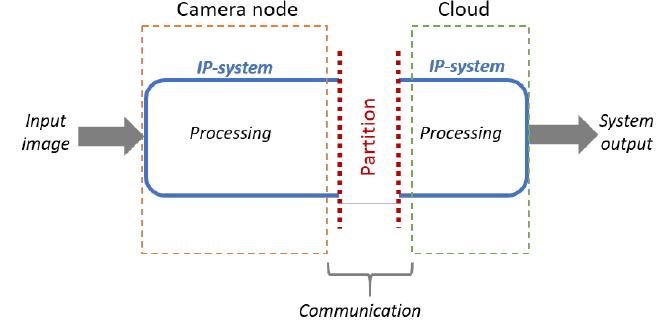
Figure 1. Intelligence